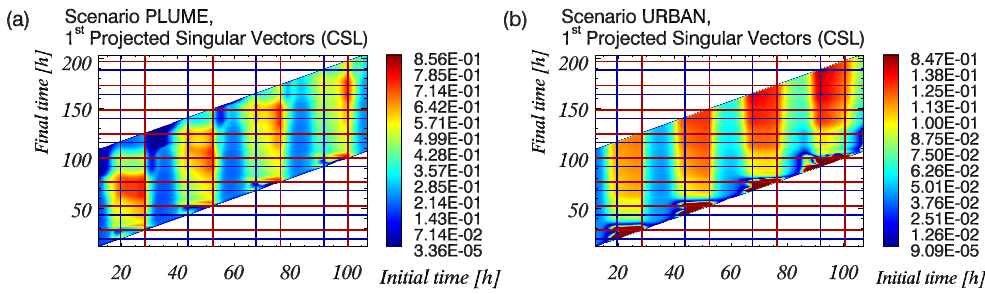
Fig. 3. CSL-section of the TSVD of optimal projected singular vectors with respect to initial uncertainties for scenarios (a) PLUME and (b) URBAN. The organisation of the results follows the schematic diagram displayed in Fig. 1. Each colour pixel indicates an individual singular vector calculation with initial time t I and final time t F . To aid interpretation, singular vectors were set to unit length. Furthermore, sunrises are marked with red lines and sunsets with blue lines, respectively.